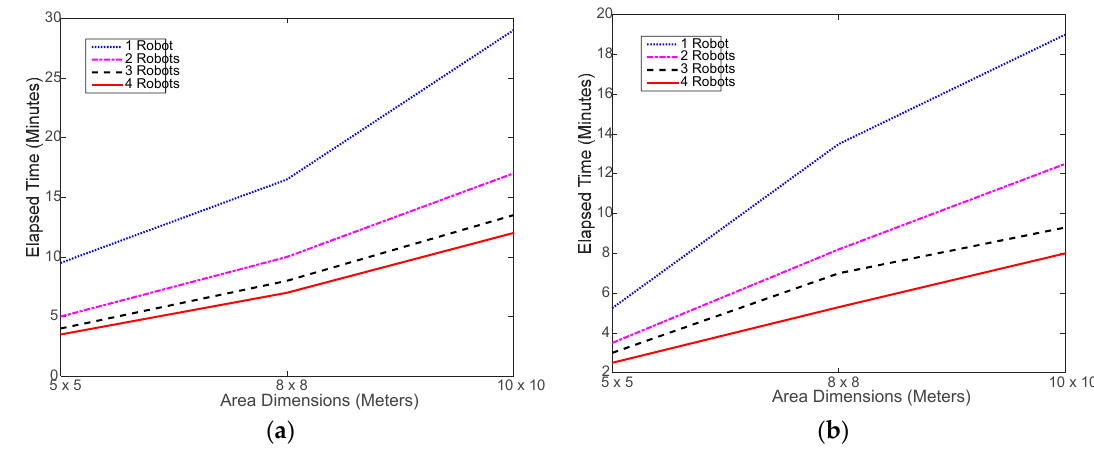
Figure 7. Elapsed time of running the experimental navigation and collecting required RSSI samples: ( a ) using distributed WiMAP algorithm; ( b ) using distributed DWiMAP.